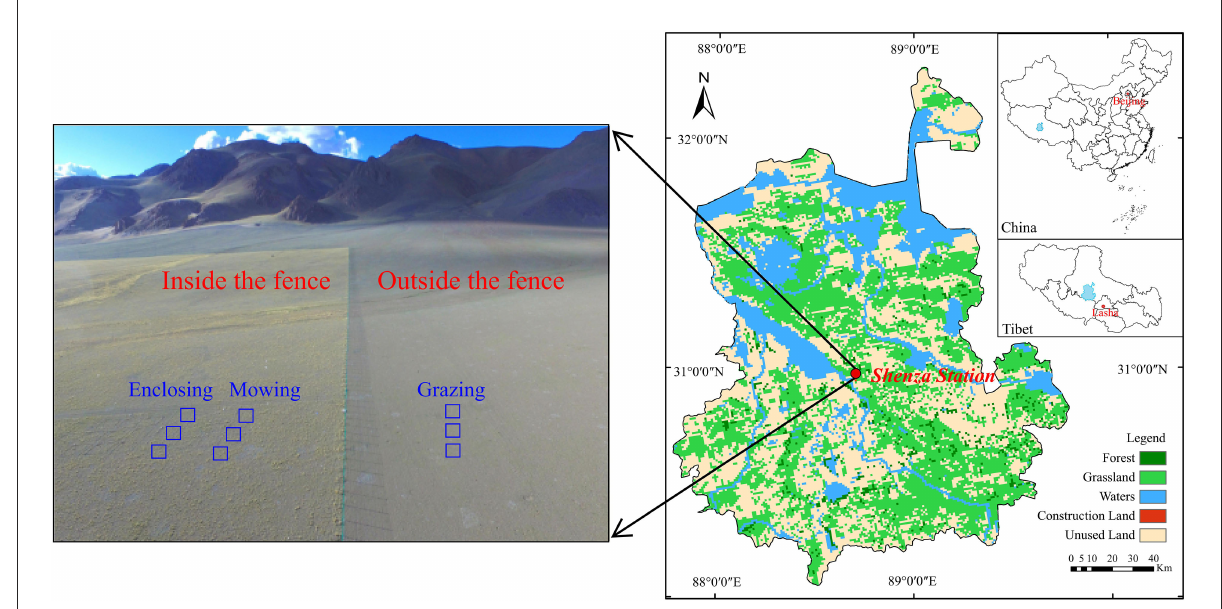
FIGURE1 Location of the study area and experimental layout inside and outside the